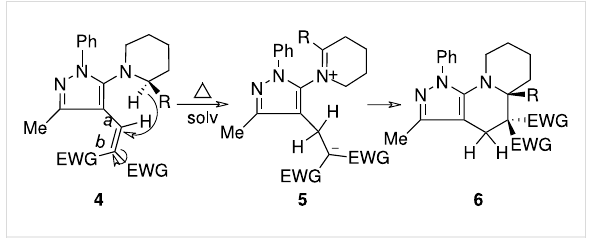
Scheme 2: Mechanism for the formation of pyrazolinoquinolizines